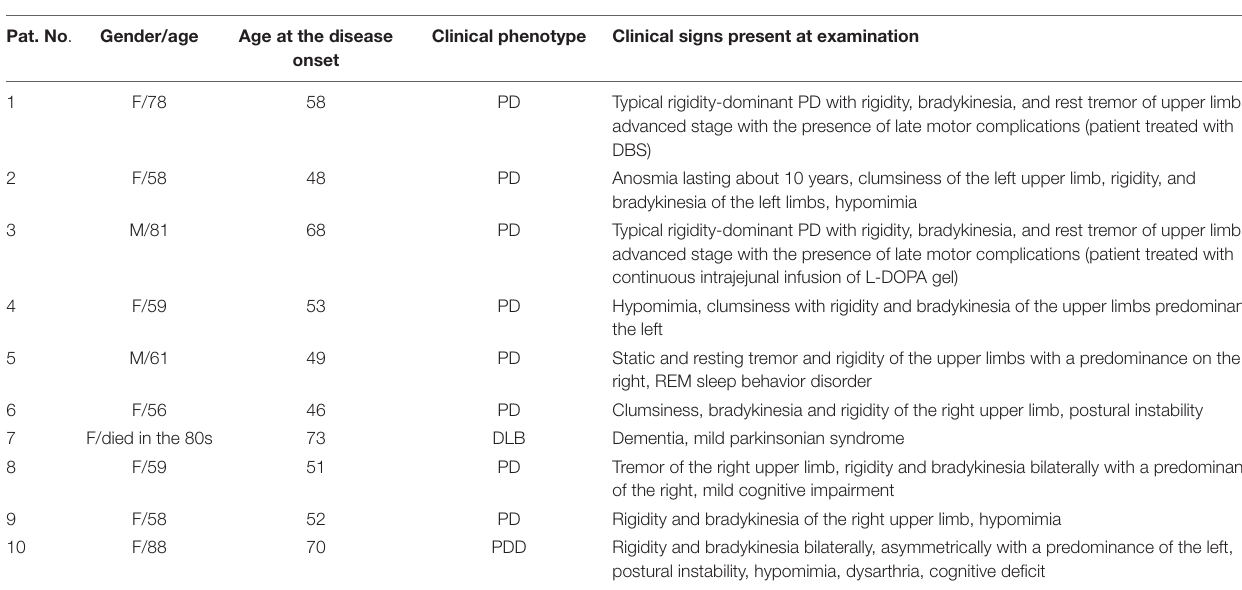
Data about age of patients and controls in individual trios, patients’ number in our study and its sex is given in brackets. TABLE 2 | Summary of patient clinical